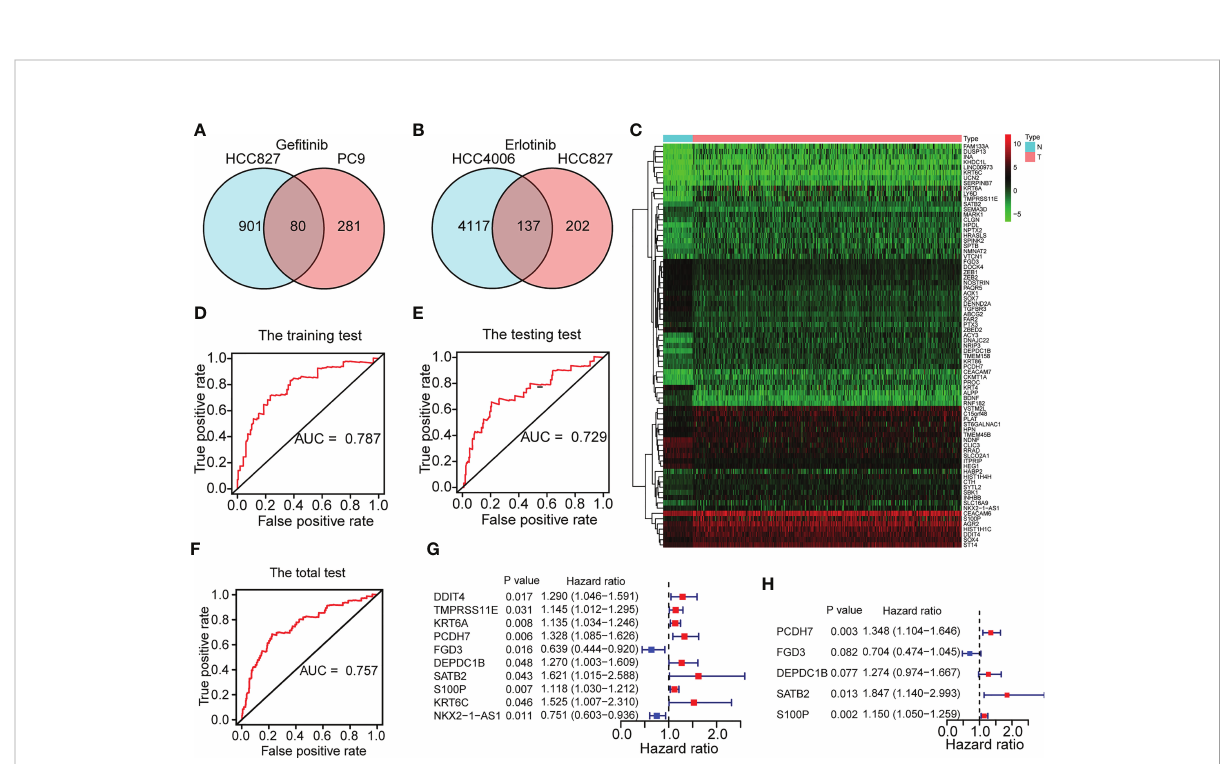
FIGURE 2 Construction of a fi ve-gene ERS for predicting prognoses. (A) 80 ge fi tinib resistance-related genes were identi fi ed through the GEO datasets of GSE60189 and GSE122005. (B) 137 erlotinib resistance-related genes were identi fi ed through GSE80344. (C) 77 differentially expressed EGFR- TKI resistance-related genes were identi fi ed between the normal (N) and tumor (T) groups of TCGA-LUAD cohort. (D – F) The training set and testing set of TCGA-LUAD cohort respectively for risk model construction and validation were chosen until the ROC curves of the two sets reached a best predictive value. The ROC curve in the total set of TCGA-LUAD cohort was also shown. (G – H) Five genes (FGD3, PCDH7, DEPDC1B, SATB2, and S100P) were selected for risk model development based on univariate and multivariate Cox regression analyses conducted on the training set of the TCGA-LUAD